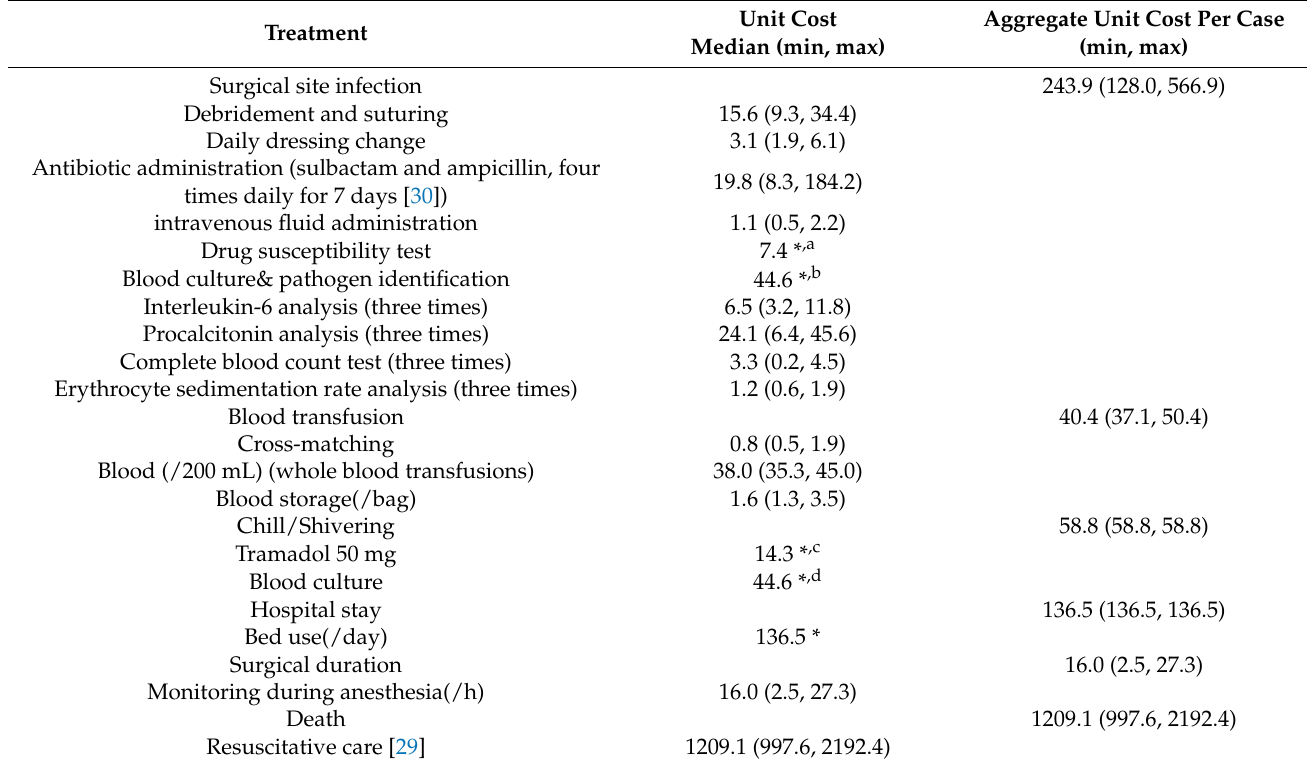
Table 1. Costs (in US dollars) of the treatment of adverse events related to intraoperative